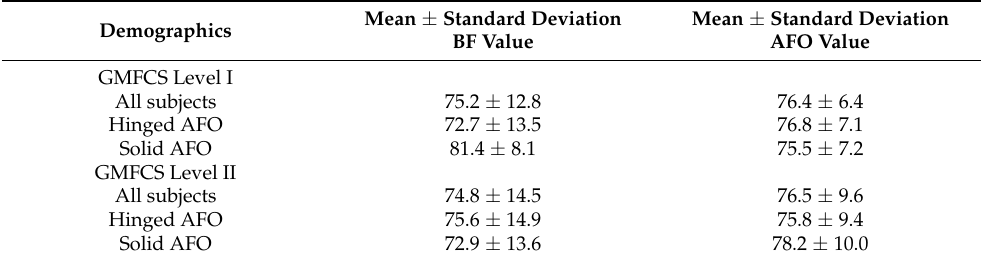
Table 4. Descriptive statistics changes in GDI scores.